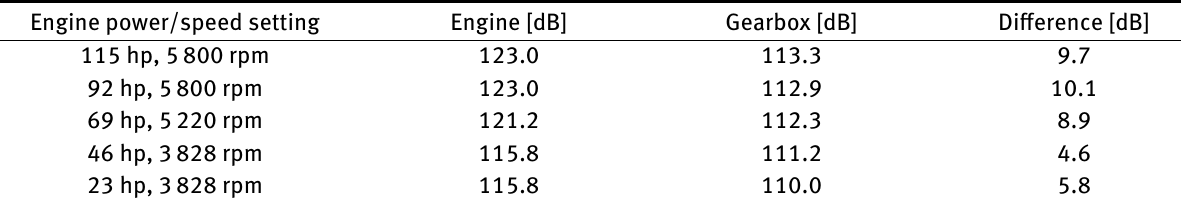
Table 4: Sound power comparison between engine and gearbox for a Pipistrel